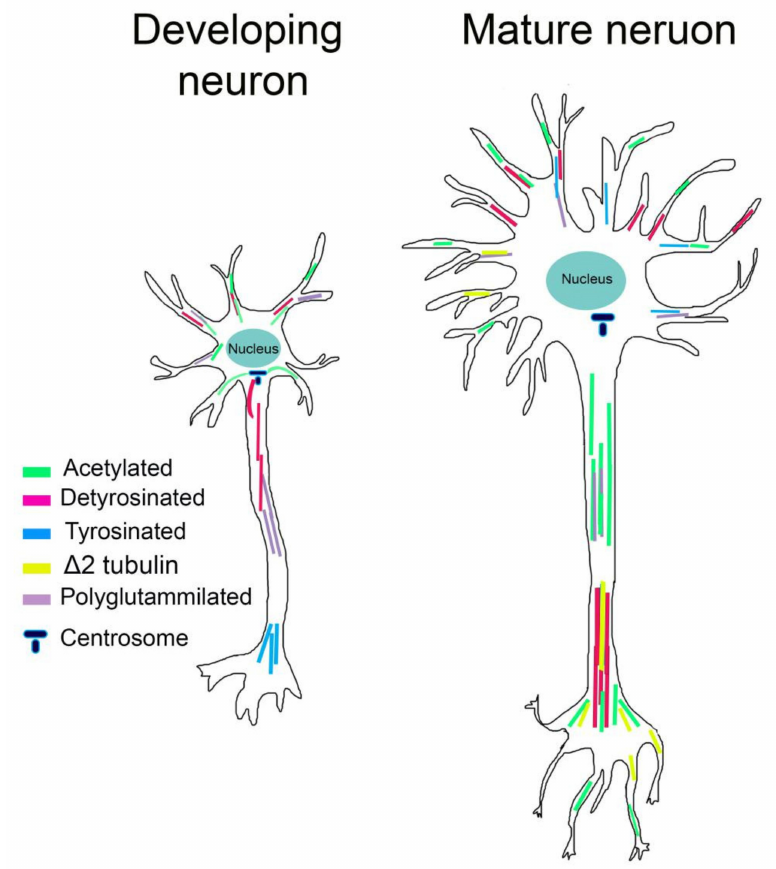
Figure 2. The distribution of tubulin post-translational modifications (PTMs) di ff ers in neuronal compartments and during neuronal di ff erentiation. In young neurons, polyglutamylation and detyrosination are elevated in the growing axon. Acetylation is localized in the cell body connecting neurite outgrowth, while tyrosination is located in distal region of axons contiguous with the growth cone. In mature neurons, acetylation increases in the proximal site of the axon and presynaptic regions. Detyrosinated and ∆ 2 tubulin levels are relatively high in di ff erentiated dendrites and